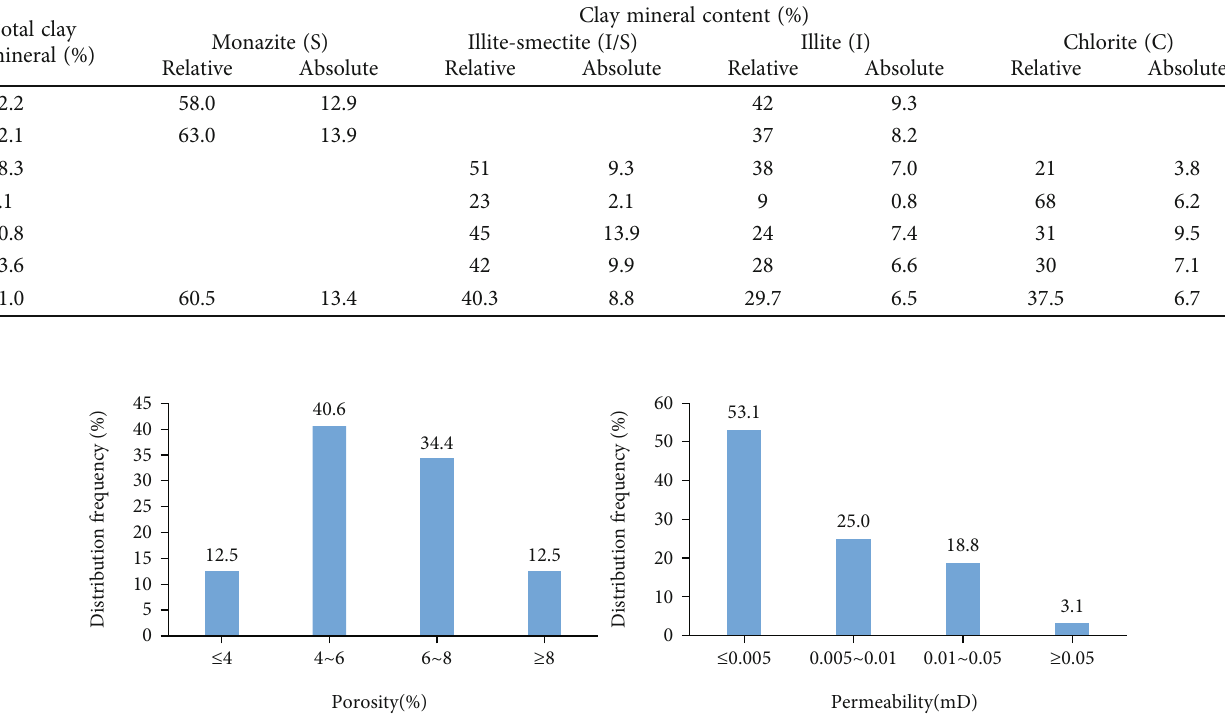
Table 3: Composition of clay minerals in intercalated cores.